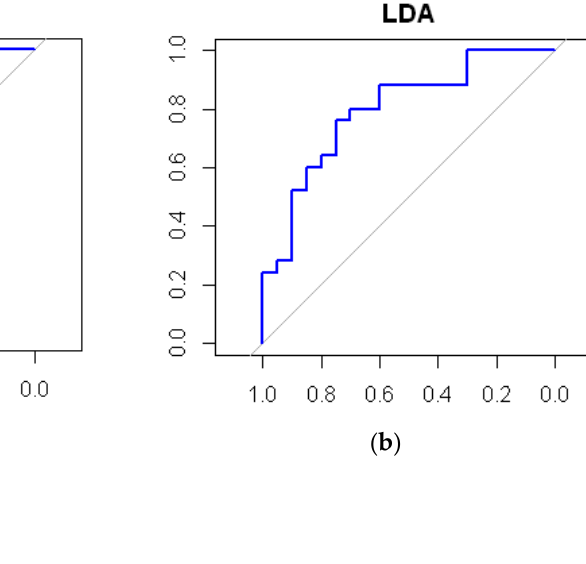
Table 5. Comparison of averaged model scores and representative model scores based on the chosen seed values.